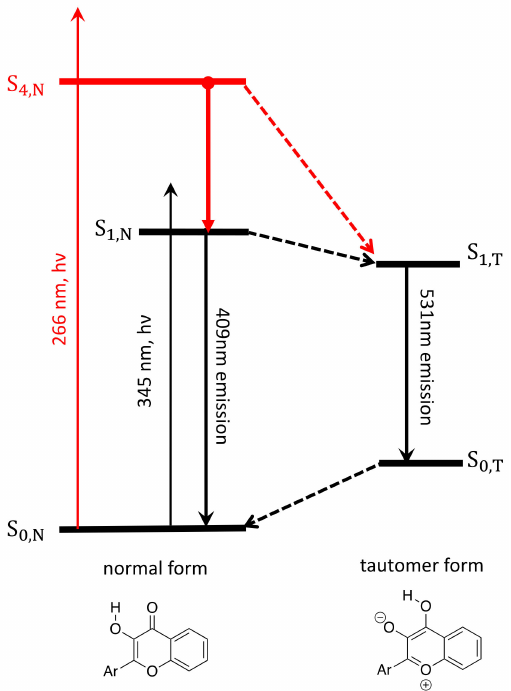
Scheme 3. Photochemistry of 3HF with higher energy excitation in red compared to the lower excitation energy in